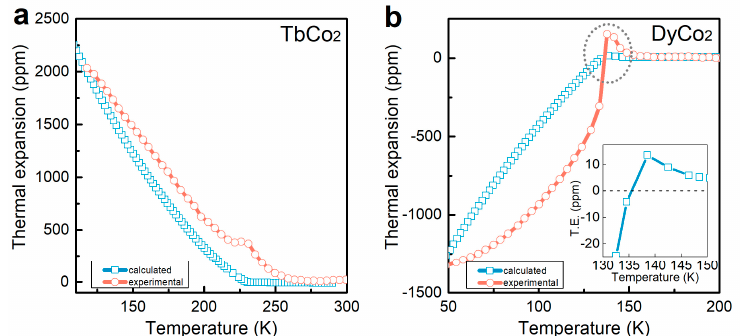
Figure 4. (Color online) The comparison between the calculated thermal expansion curve and the experimentally measured curve for TbCo 2 ( a ) and DyCo 2 ( b ).